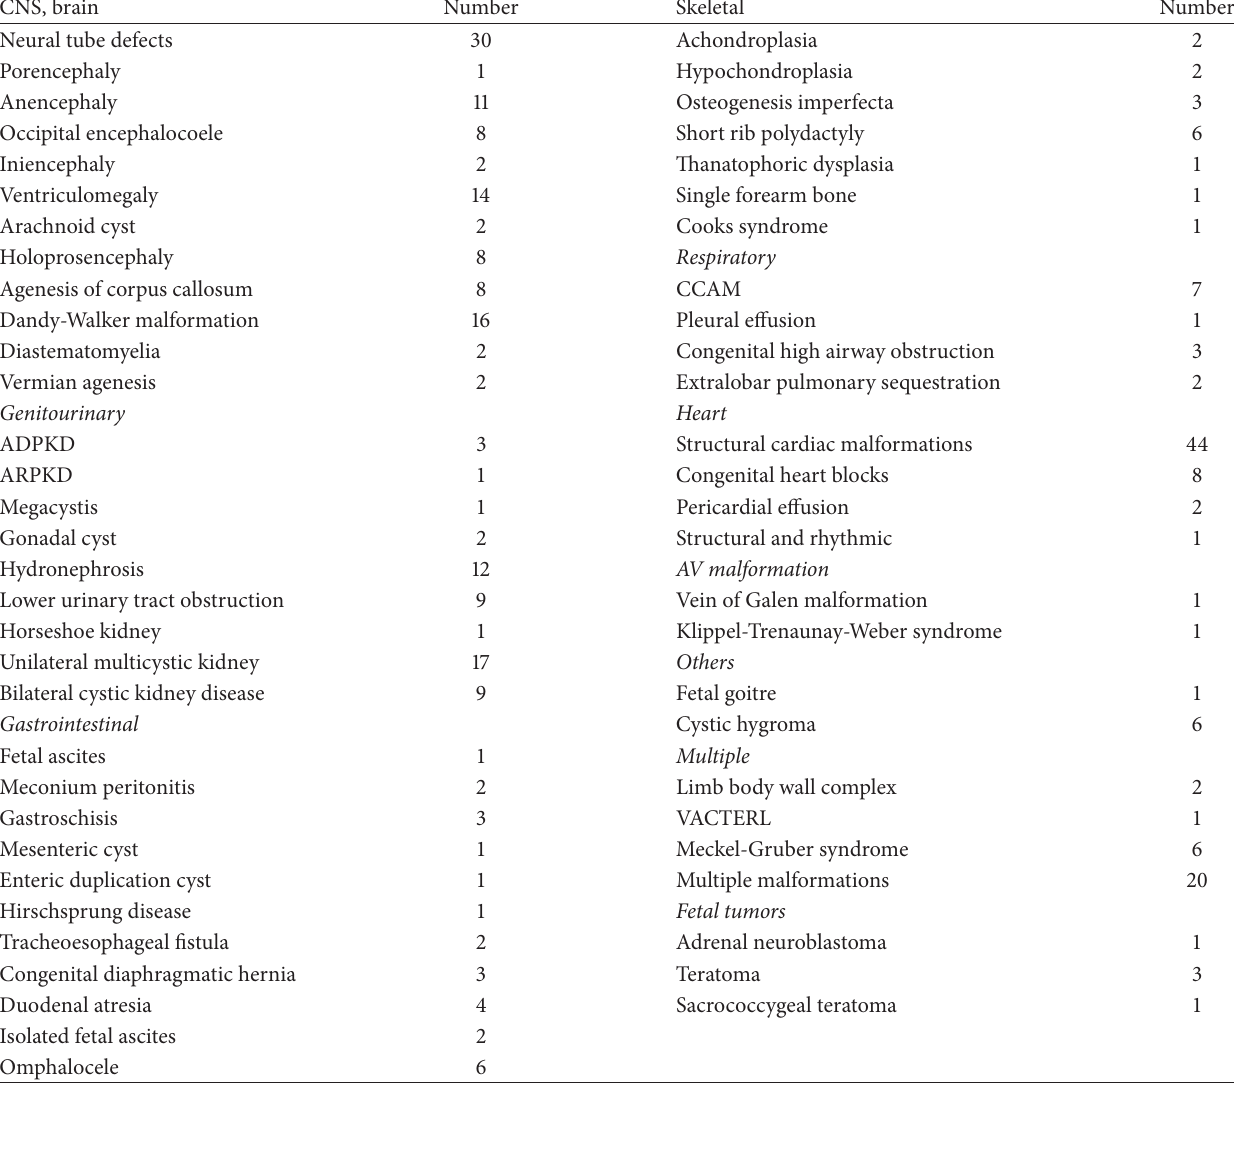
Table 2: Classification of malformation according to the system involved.